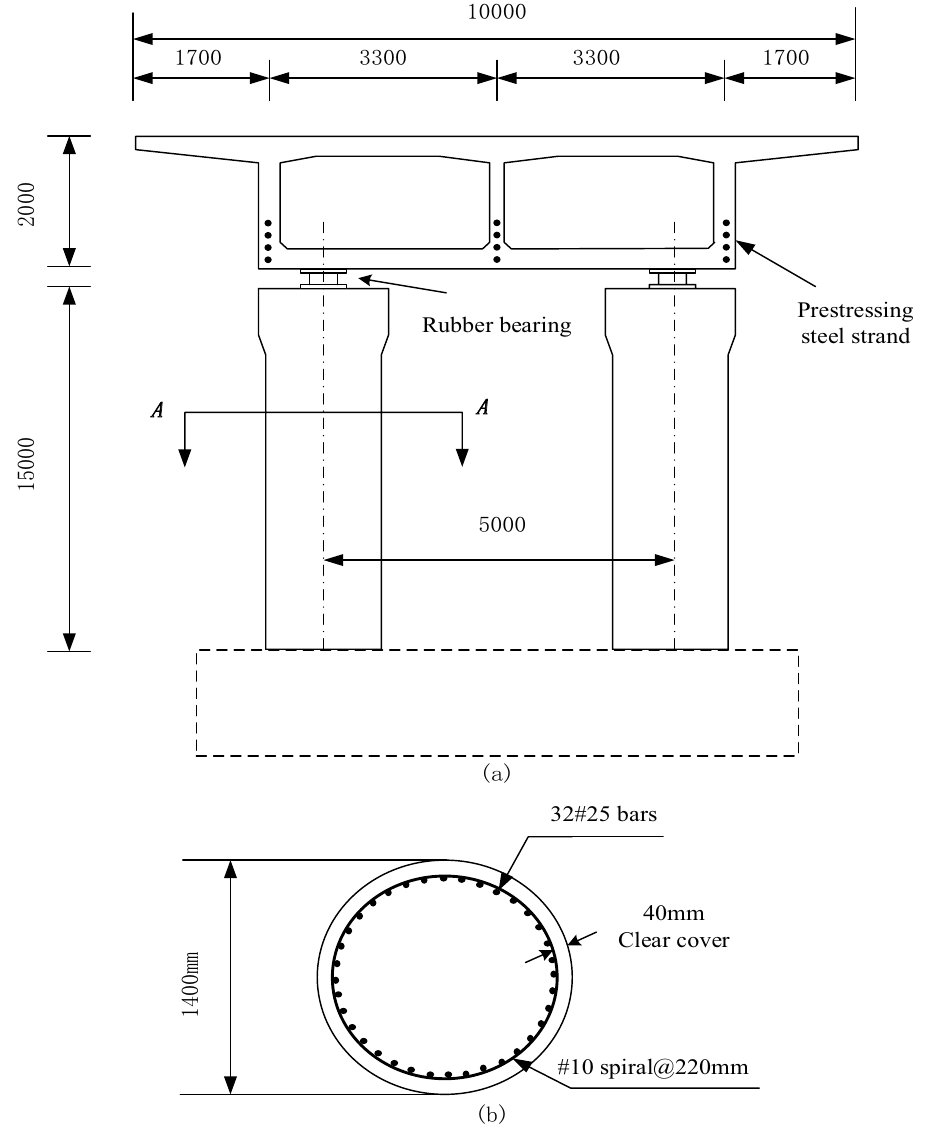
Figure 2. Dimensions and details of the bridge elevation and section